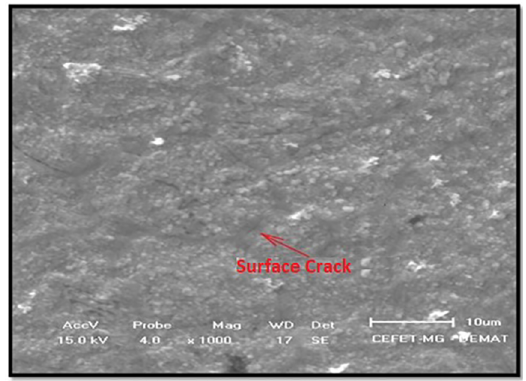
Figure 2. The substrate of stain steel after coating by black chromium.